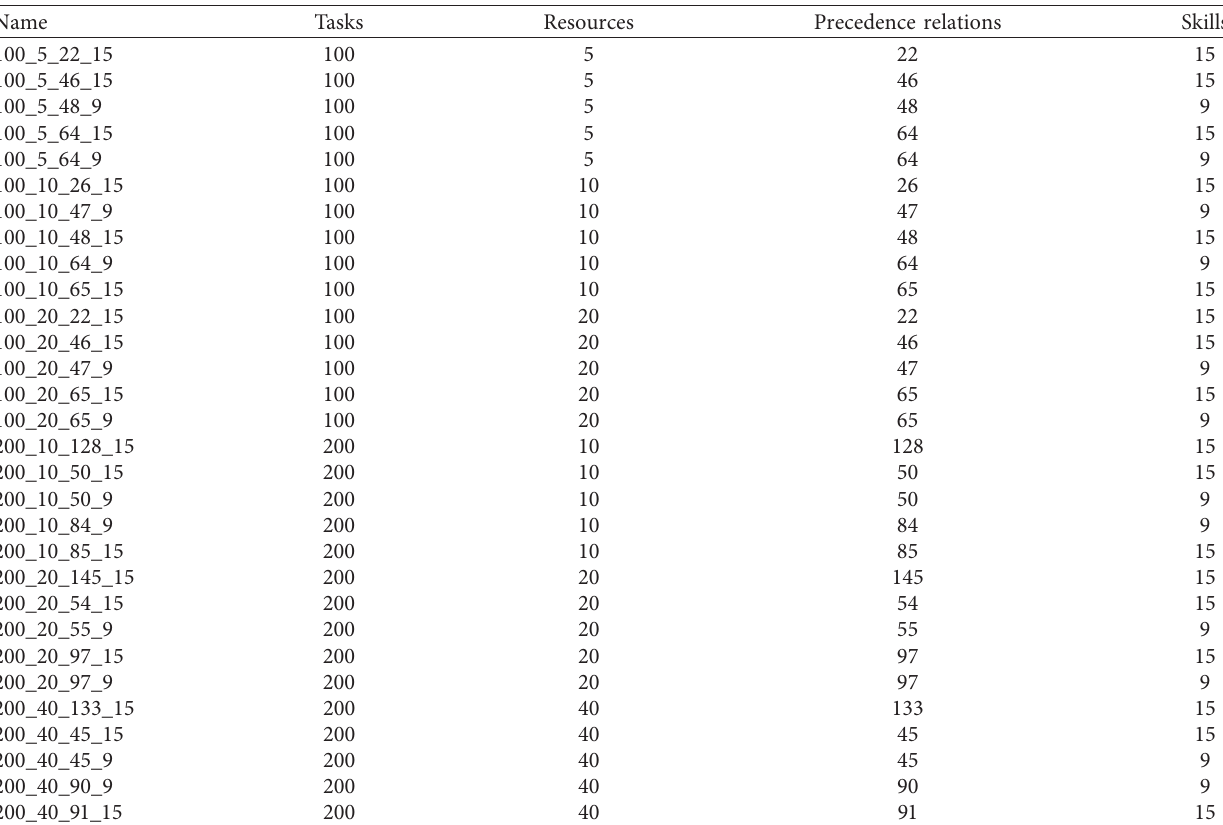
Table 5: iMOPSE benchmark